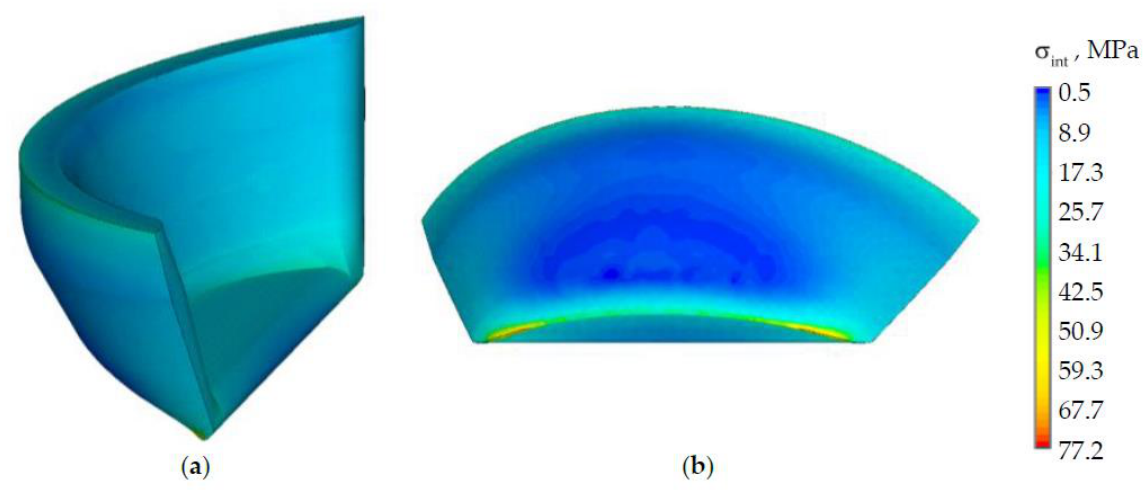
Figure 7. Stress intensity of the inlay: ( a ) is general view, ( b ) is outer side. The level of the stress intensity in the area of the prosthetic inlay is comparable to the stresses in the tooth without defects. The maximum stress intensity in the tooth-inlay sys- tem has shifted to the cervical area of the tooth.